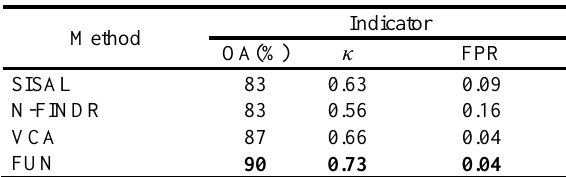
Figure 3. The result of multiple change maps detected by different endmember extraction algorithms for China data set. (a) SISAL, (b) N-FINDR, (c) VCA, (d) FUN, and (e) multiple change map ground truth. Table 1. Numerical evaluation of different hyperspectral CD methods in China data